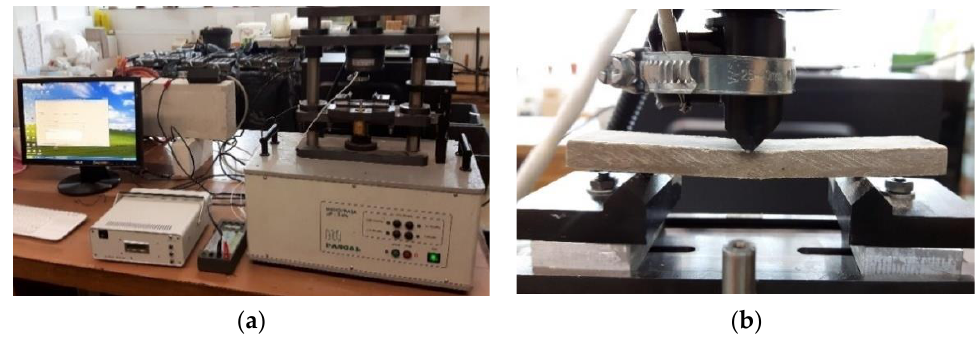
Figure 3. Test bench with equipment for acoustic emission measurements ( a ) and close-up of cement board sample during test ( b ).